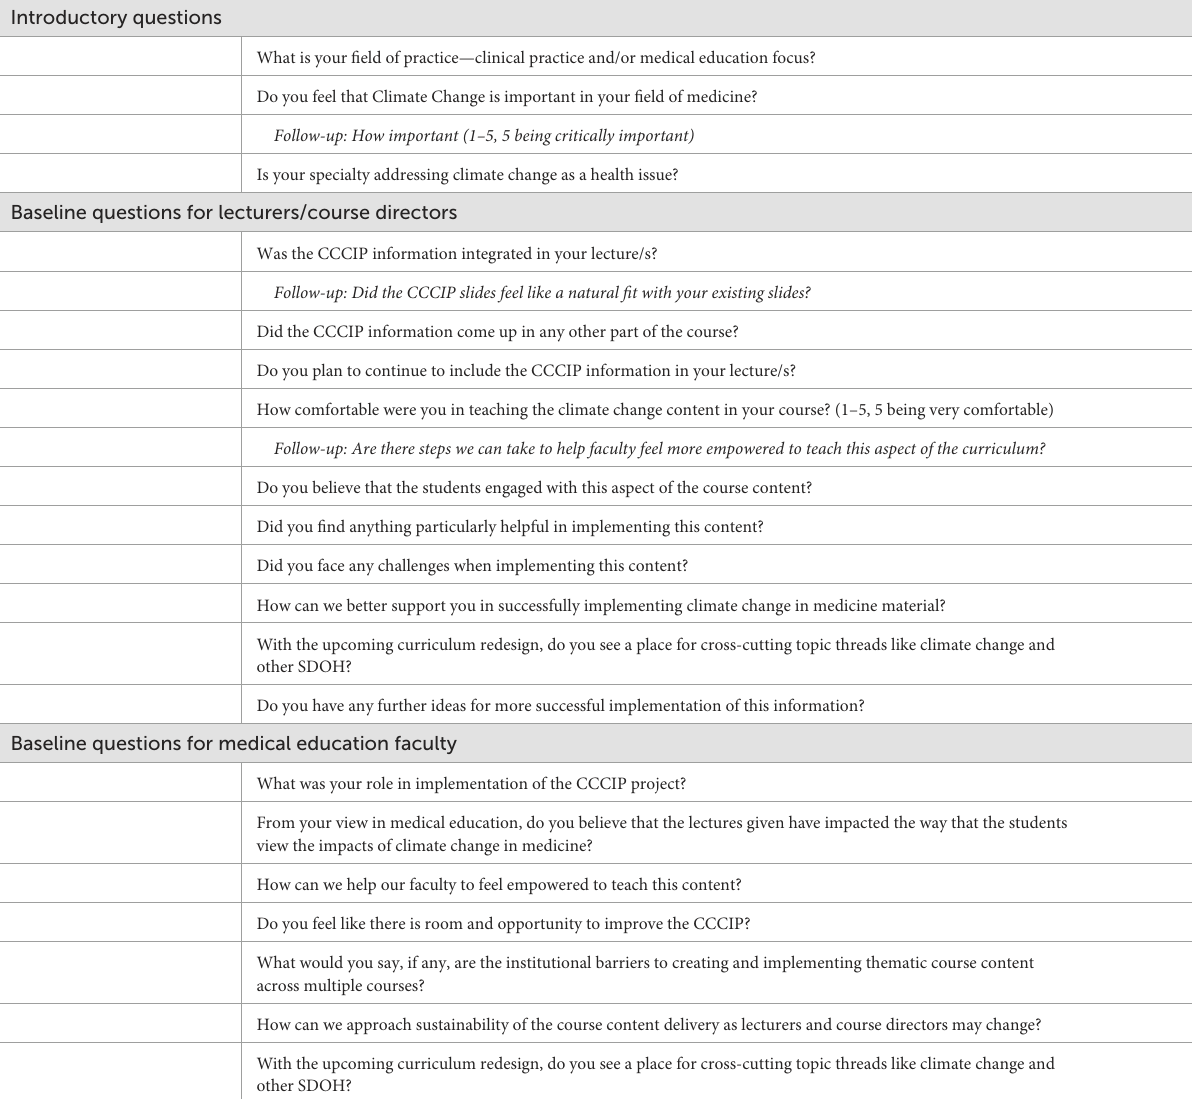
TABLE 1 Closed and open interview questions for the semi-structured interviews for the climate content